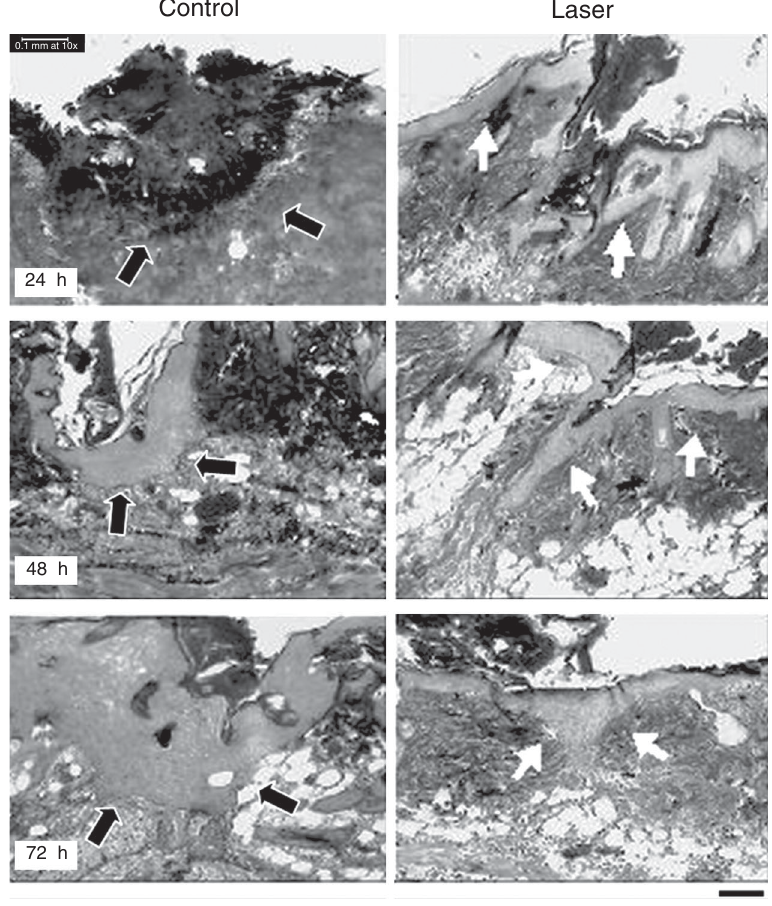
Figure 1. Photomicrograph of the skin wound of control (left, black arrows) and laser therapy (right, white arrows) groups at 24, 48, and 72 h. The white arrows show an accelerated healing process induced by He-Ne laser in the experimental groups (Masson’s trichrome; scale bar: 0.1 mm at